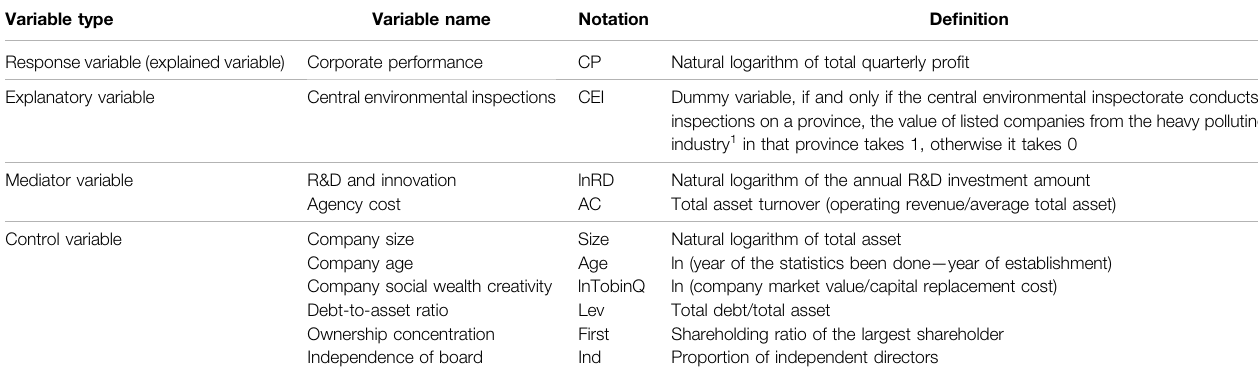
TABLE 2 | De fi nition of main